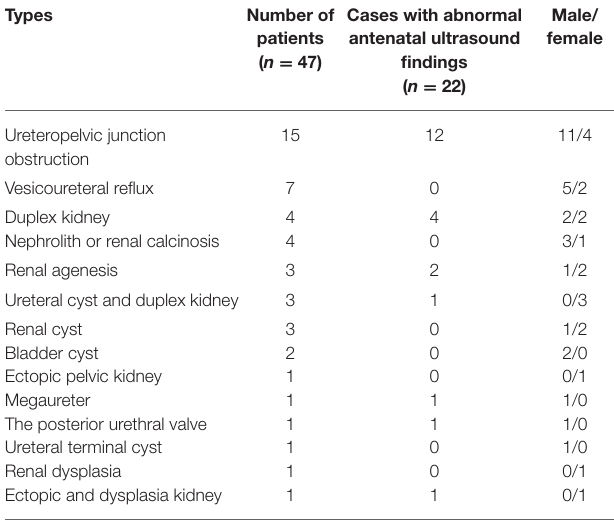
TABLE 1 | Specific disorders found in examination of 47 cases following ultrasonographic